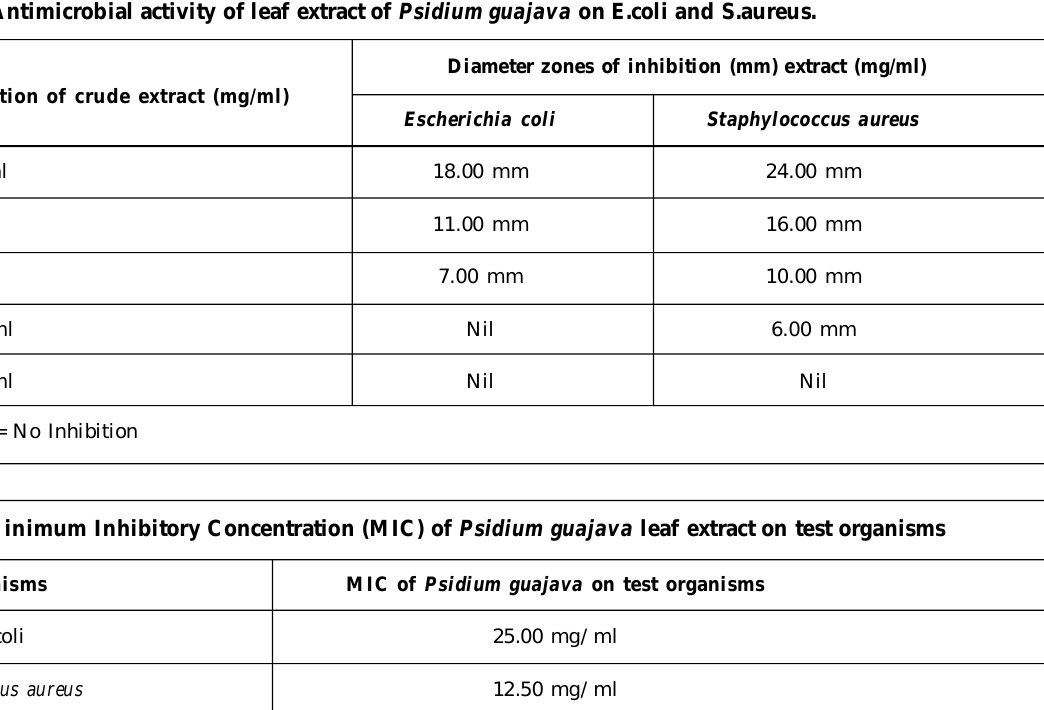
Table 1: Antimicrobial activity of leaf extract of Psidium guajava on E.coli and S.aureus.